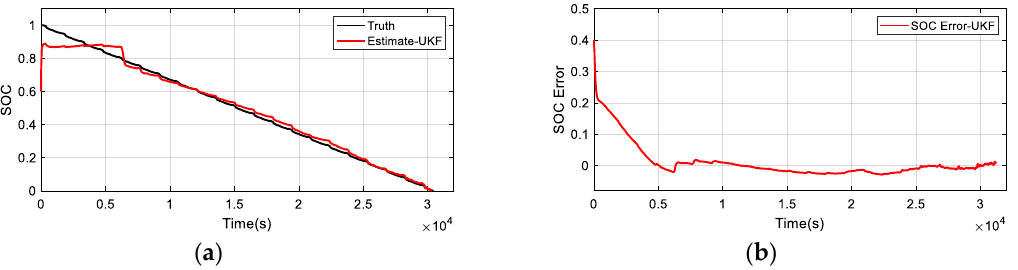
Figure 10. The battery SOC estimation result was estimated using the UKF algorithm. ( a ) Estimated value and true value of SOC of the battery. ( b ) Estimated error value of SOC of the